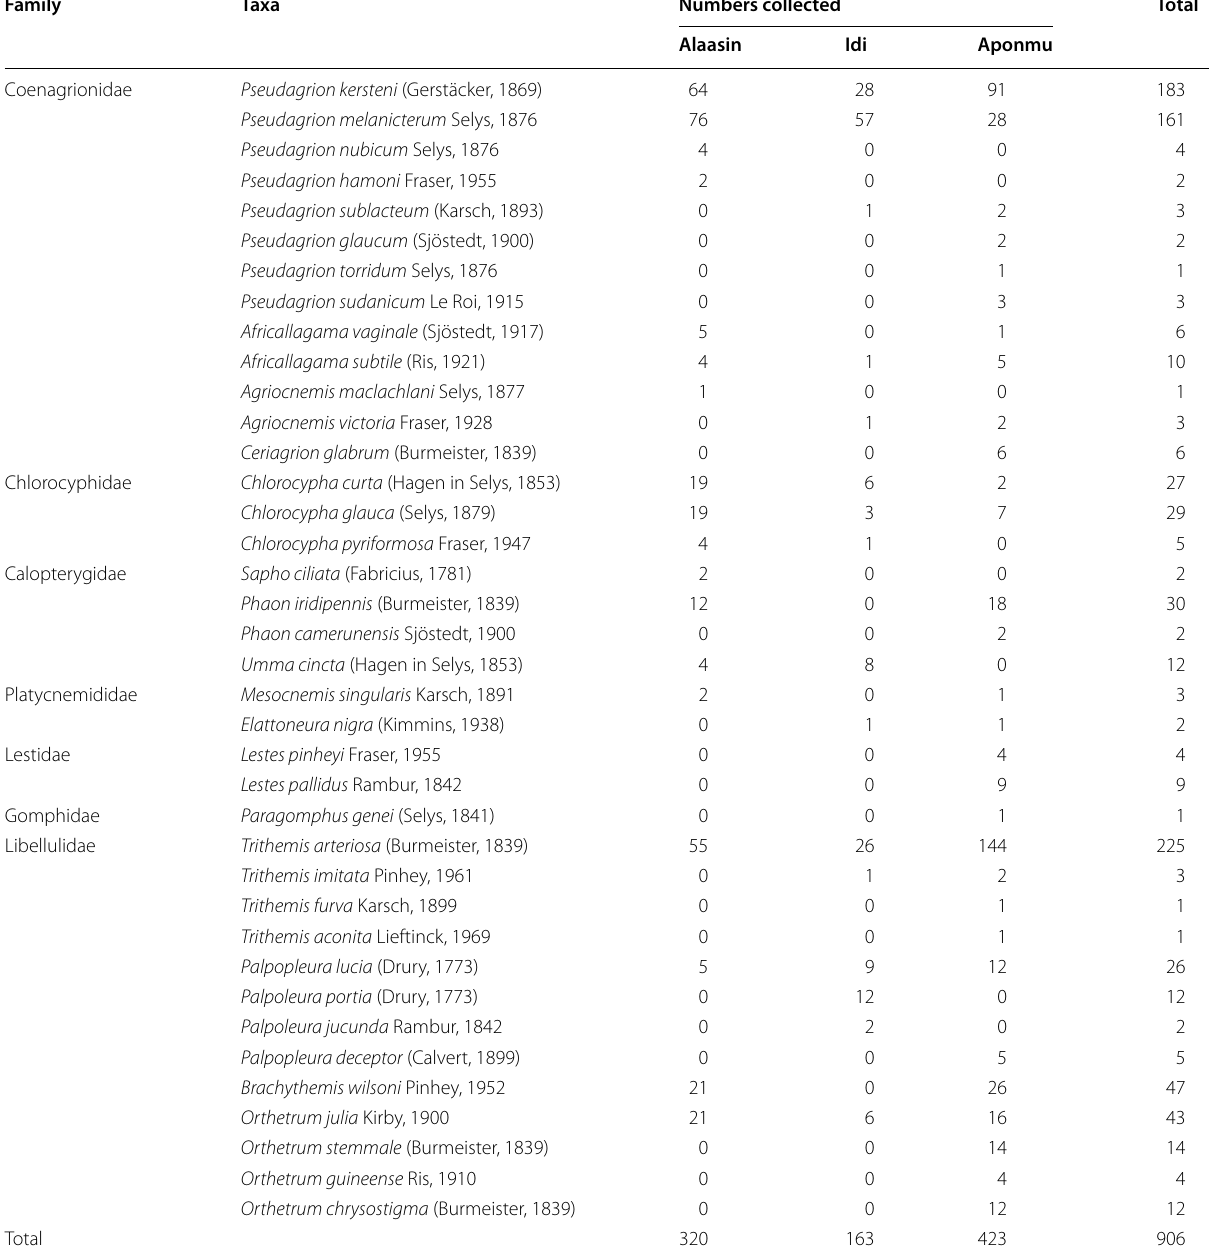
Table 1 Checklist of Odonata collected from three sites along River Aponmu in Ipogun Family